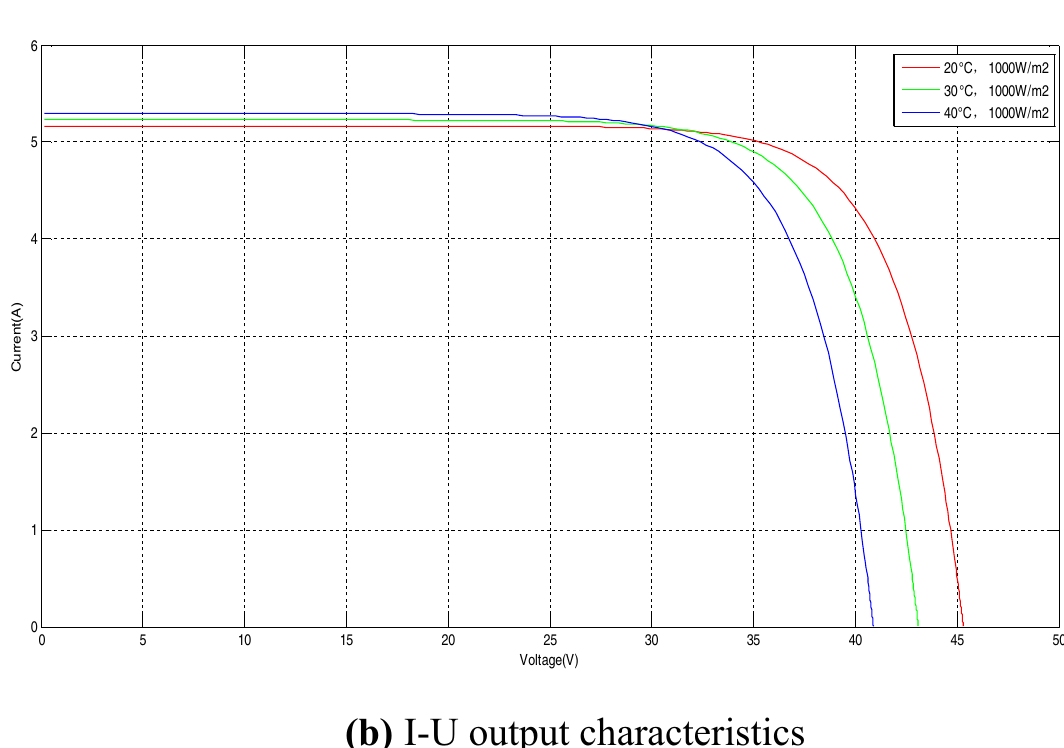
Figure 4. The output characteristics of PV panel when the temperature